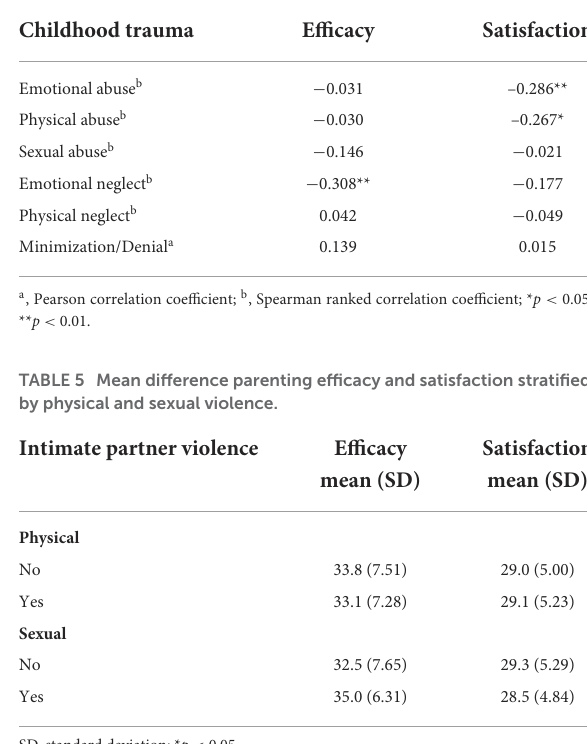
TABLE 4 Correlation between childhood trauma with parenting competence scale domains (efficacy and satisfaction).